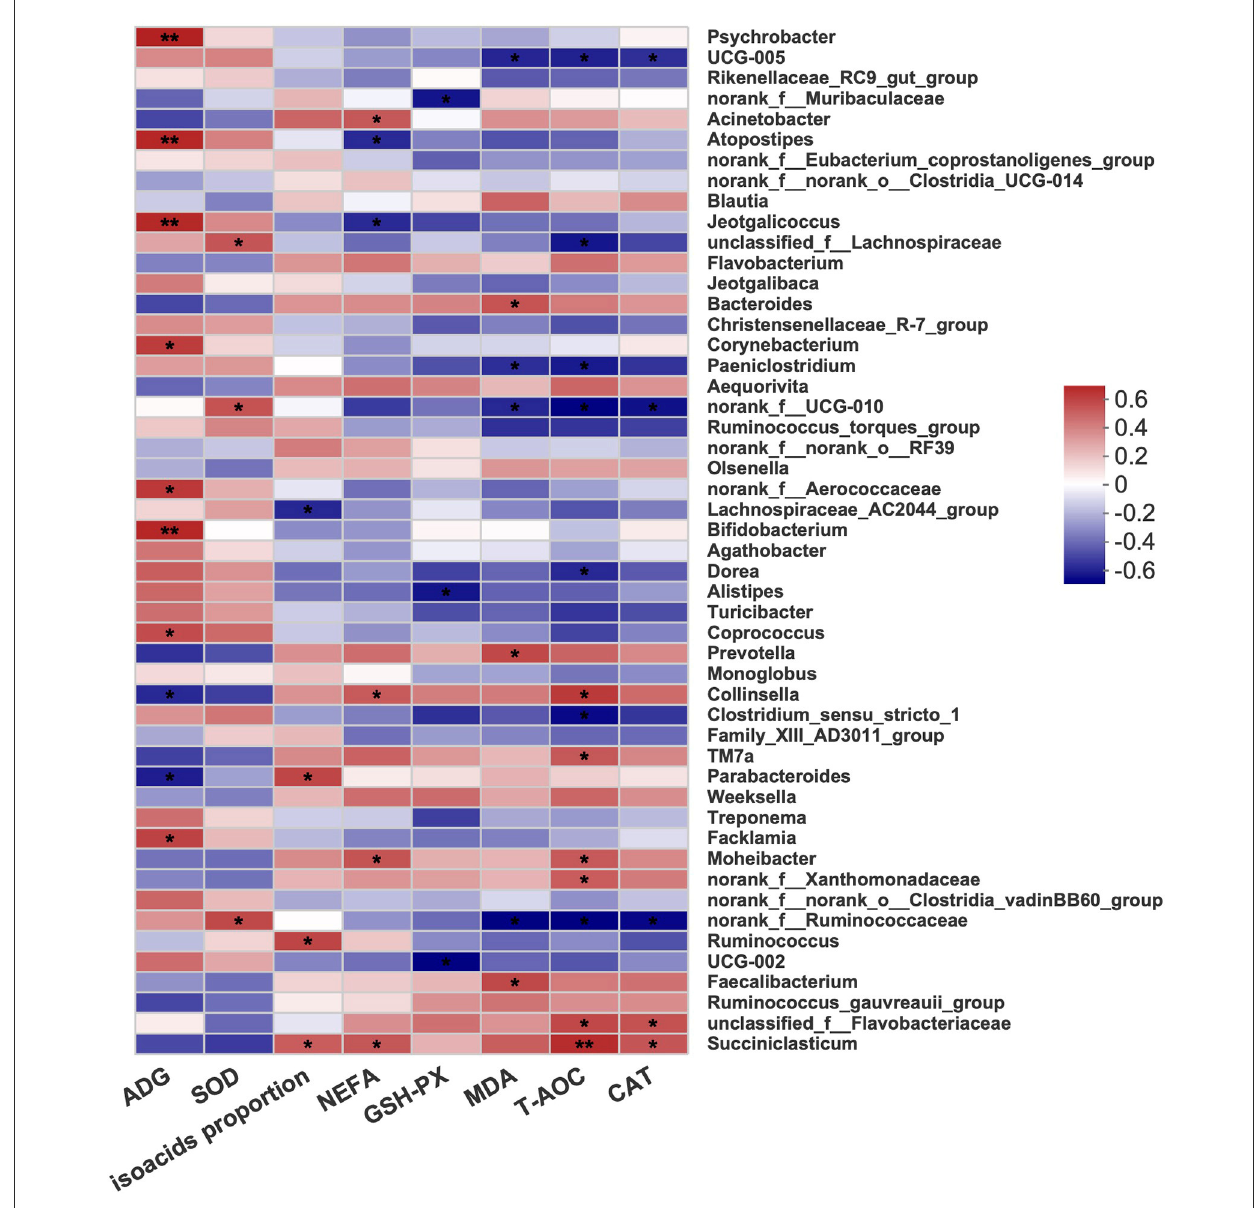
FIGURE4 Heatmap diagram of correlations between fecal bacterial and performance and blood parameters at the genus level. Red was positively correlated and blue was negatively correlated. C, calves fed fresh milk; MR, calves fed milk replacer; MRE, calves fed milk replacer plus ethoxyquin. N = 5 in each group. Correlation significance P -value was indicated by “*”. * P < 0.05, ** P < 0.01. ADG: average daily gain; SOD, superoxide dismutase; NEFA, nonesterified fatty acid; GSH-PX, glutathione peroxidase; MDA, malonaldehyde; T-AOC, total antioxidant capacity; CAT,